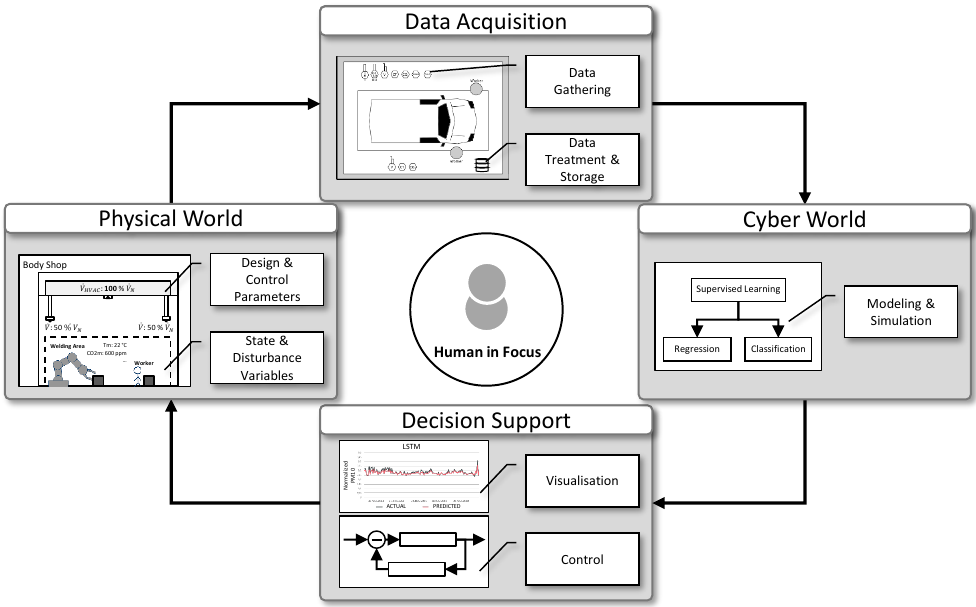
Figure 1. Schematic of CPPS framework for the use case based on the work in